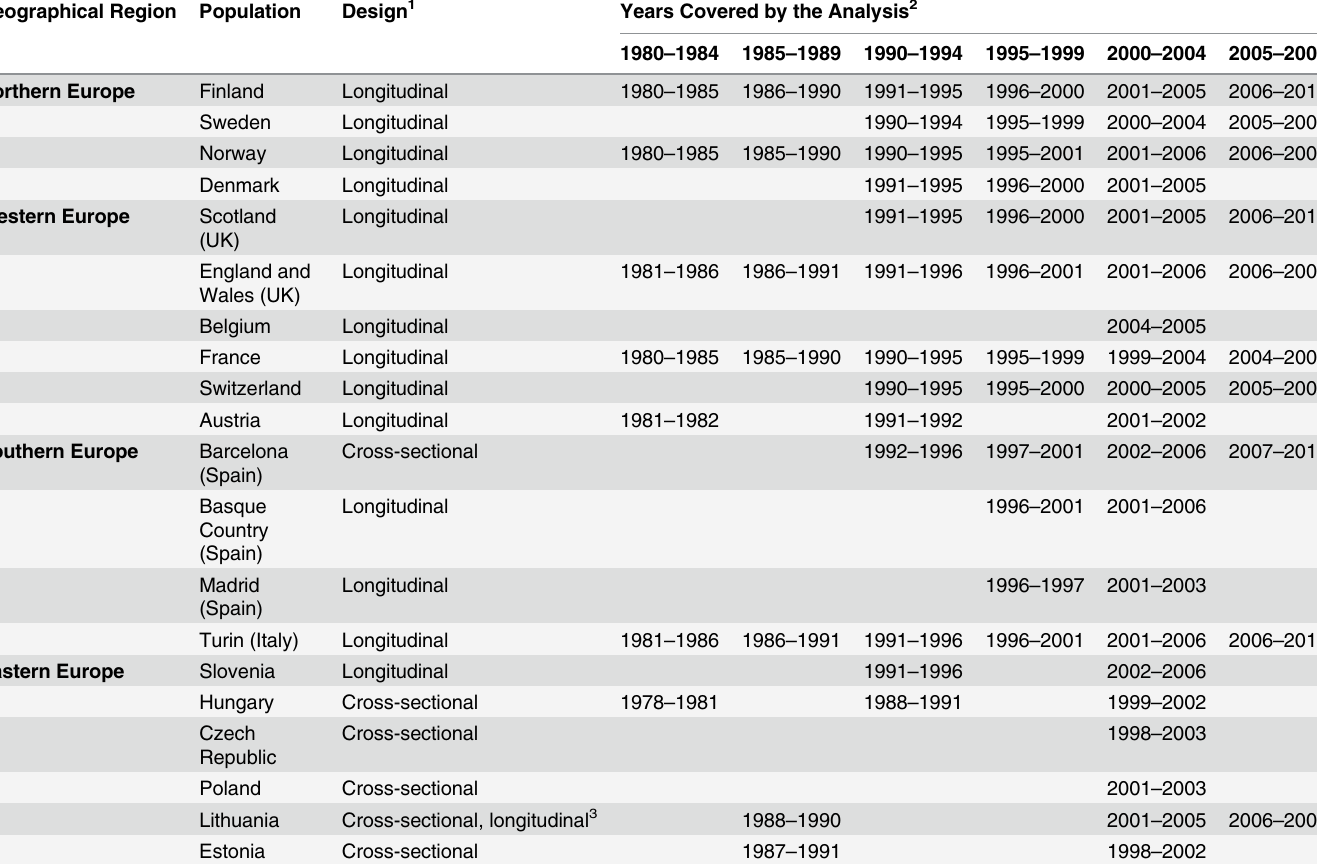
Table 1. Overview of data sources. Geographical Region